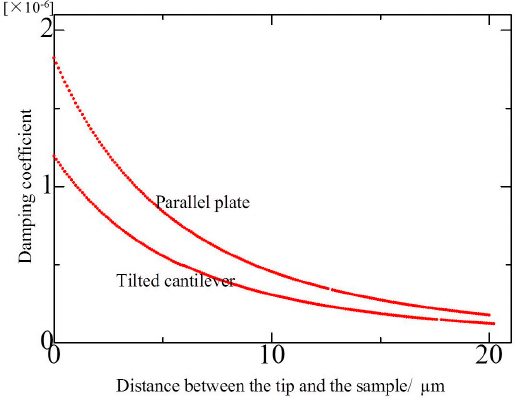
Figure 2. Dependence of damping coefficient on the tip–sample distance.